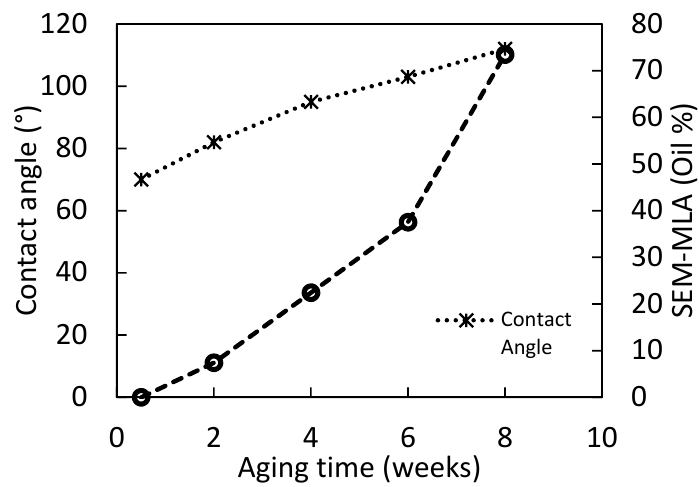
Figure 5. Comparison of contact angle data and SEM-MLA data for Berea.